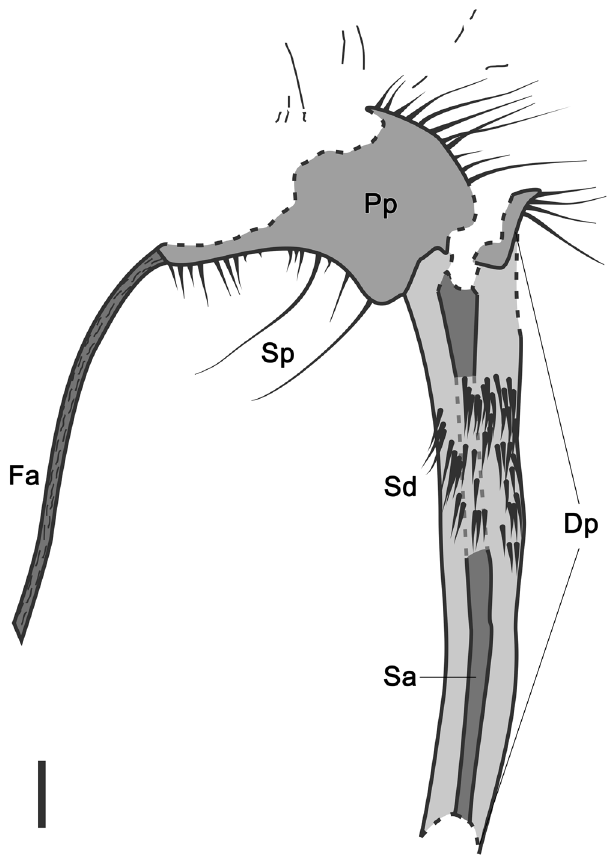
Fig. 3 Interpretative line drawing of the strobilus in the type specimen. Fa fertile axis, Pp proximal portion of the strobilus, Dp distal portion of the strobilus, Sp Sporophylls on the proximal portion, with long, radiating laminae, Sd Sporophylls on the distal portion, with shorter adpressed laminae pointing towards the tip of strobilus. Sa strobilar axis. Gray dashed lines indicating the covered part of strobilar axis. Black dashed lines indicating the fractures. Scale bar: 2